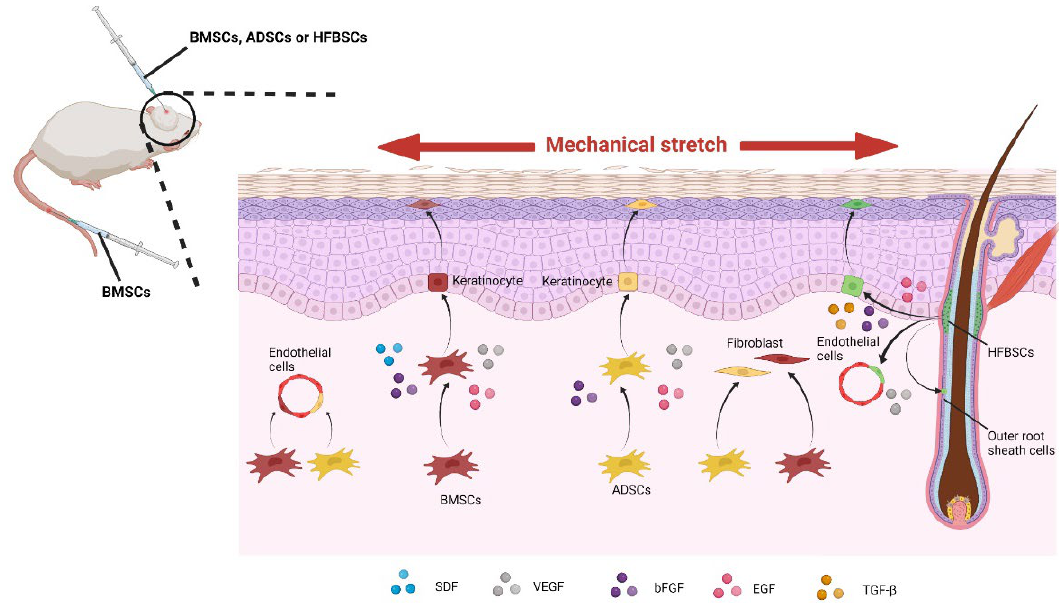
Figure 3. Under mechanical stretch, the injected bone marrow mesenchymal stem cells (BMSCs) and adipose-tissue-derived stem cells (ADSCs) differentiate into keratinocytes, fibroblasts, and endothelial cells and secrete various kinds of growth factors. In addition, hair-follicle-bulge-derived stem cells (HFBSCs) also differentiate into keratinocytes, endothelial cells, and the outer root sheath cells and secrete growth factors under mechanical